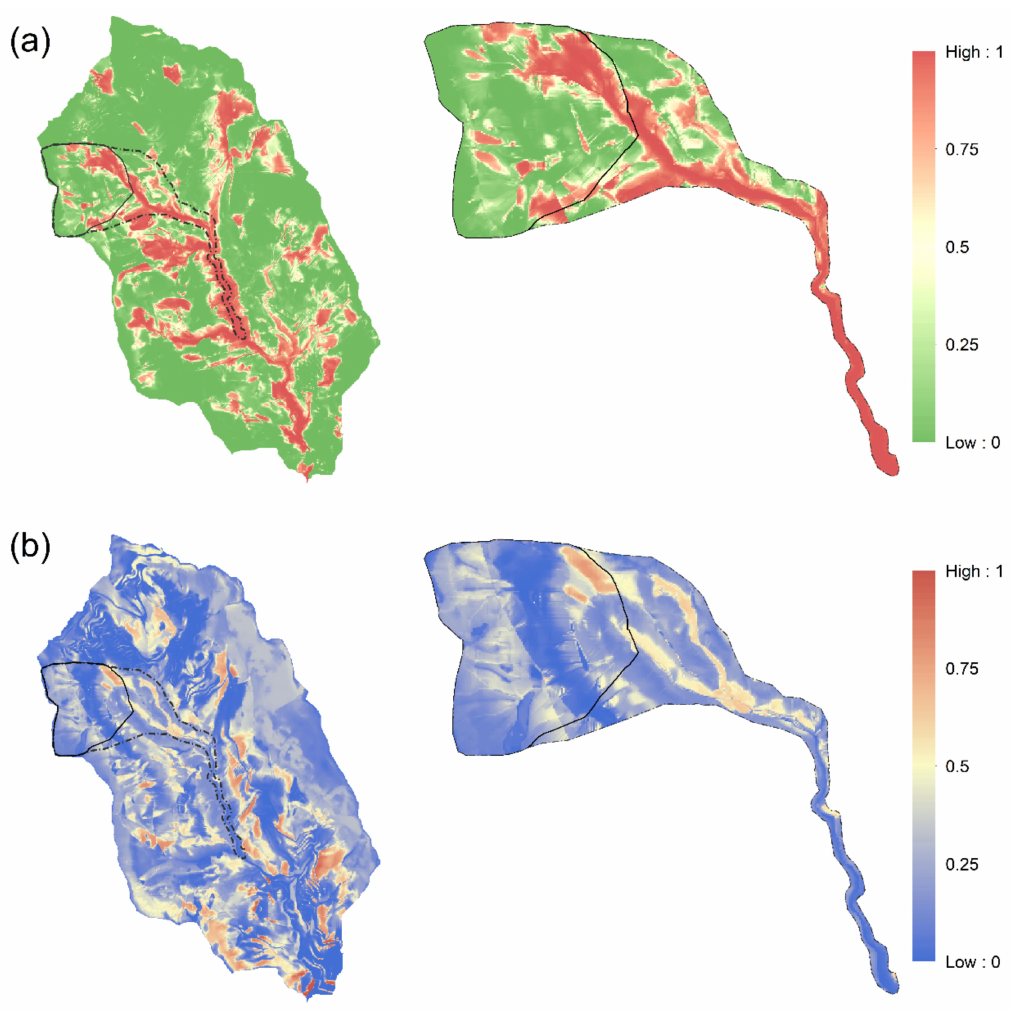
Figure 10. The prediction result of the sub-basin and Alishan D098 influence area. ( a ) Landslide susceptibility classification model; ( b ) rainfall threshold regression